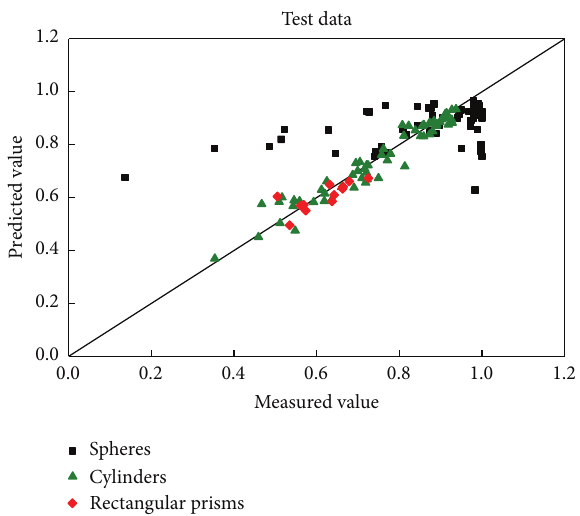
Figure 9: Comparison of the predicted and measured wall factors of all particles for the test